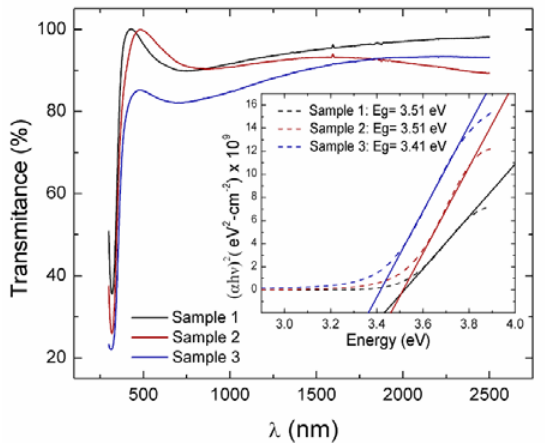
Figure 3. Transmittance spectra of AZO films. Inset: Tauc